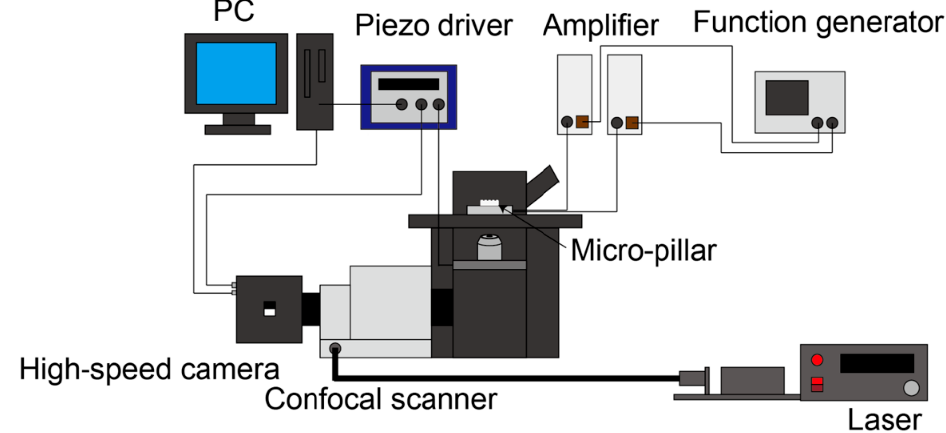
Figure 4. Schematic diagram of the confocal micro-PIV system.